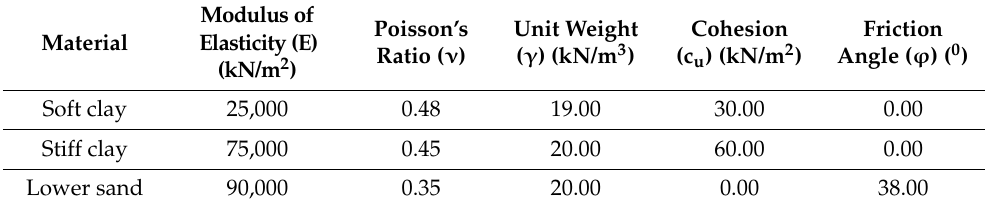
Figure 8. FEM modeling for the soil and tunnel. ( a ) Two ‐ layer soil model; ( b ) three ‐ layer soil model.